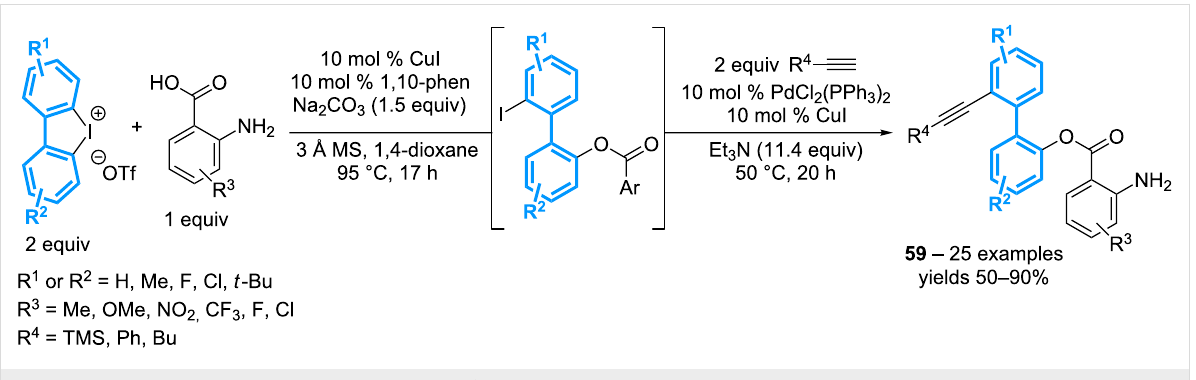
Scheme 23: Sequential difunctionalization of cyclic diaryl- λ 3 -iodanes.